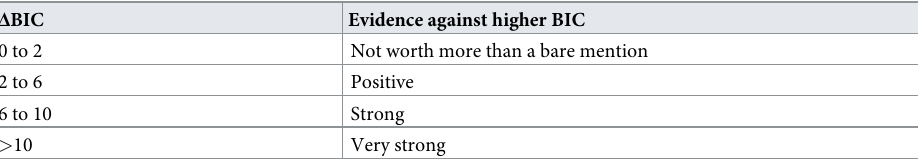
Table 3. The scale of Δ BIC in the model comparison as suggested by Kass and Raftery